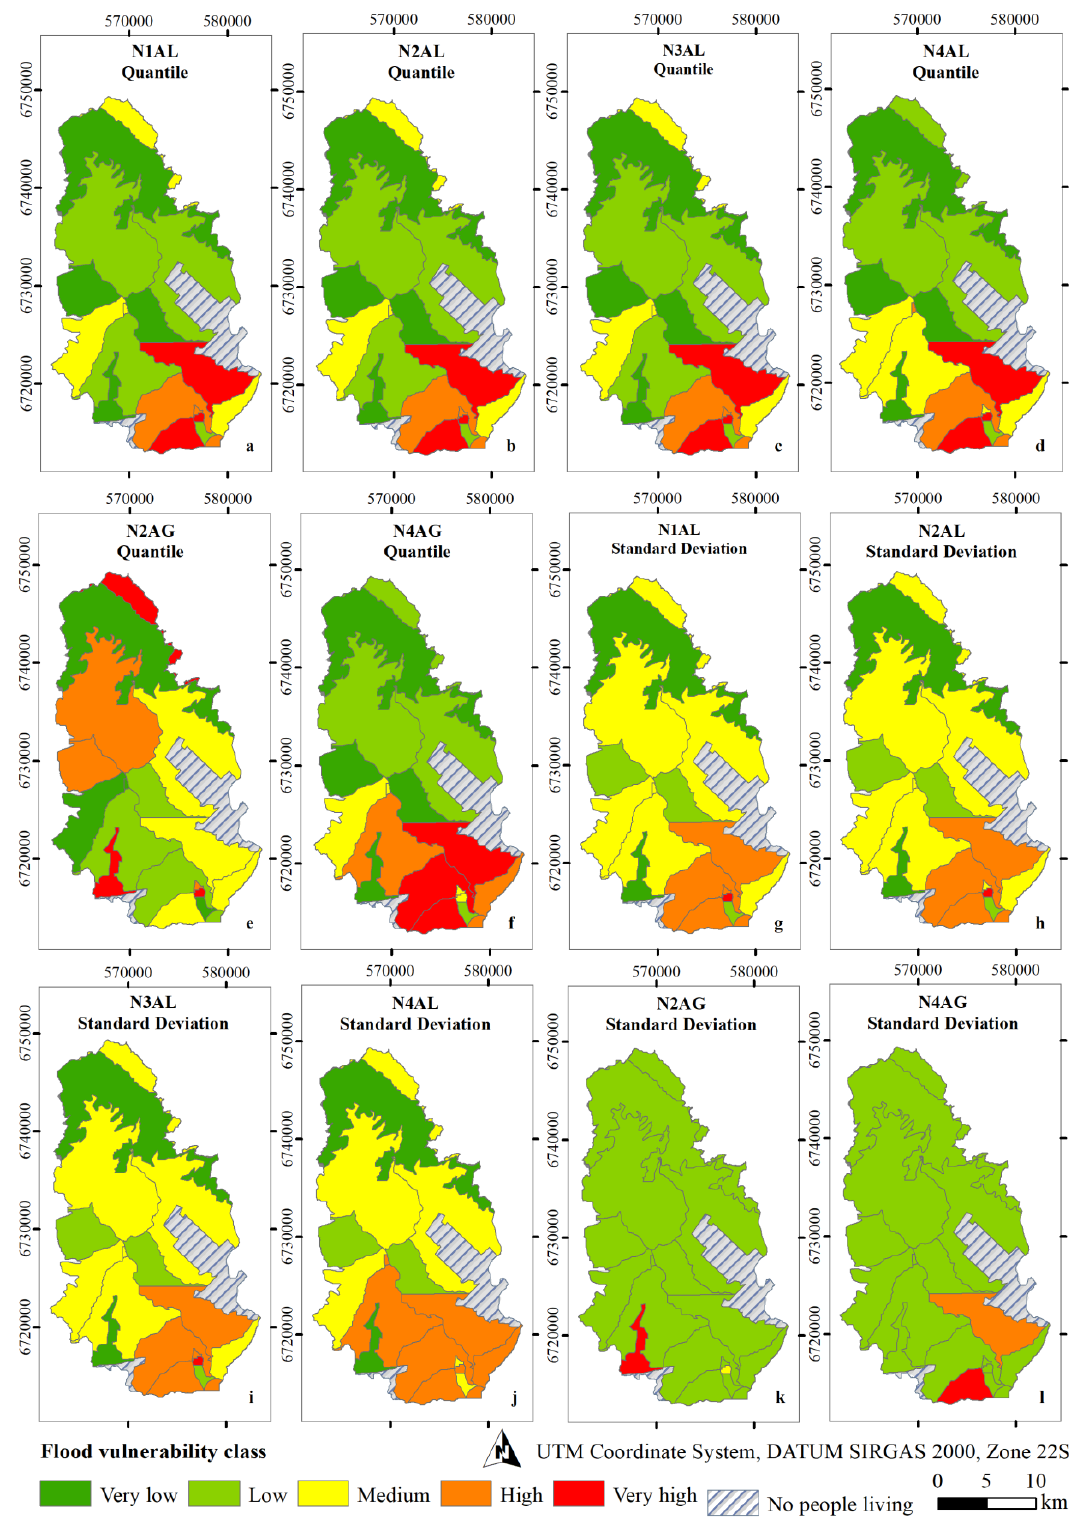
Figure 7. Vulnerability class switches for the different normalization and aggregation methods based on the quantile and standard deviation classification methods. N1 = Min-max normalization, N2 = Z-scores normalization, N3 = distance to target normalization, N4 = ranking normalization, AL = linear aggregation, and AG = geometric aggregation.